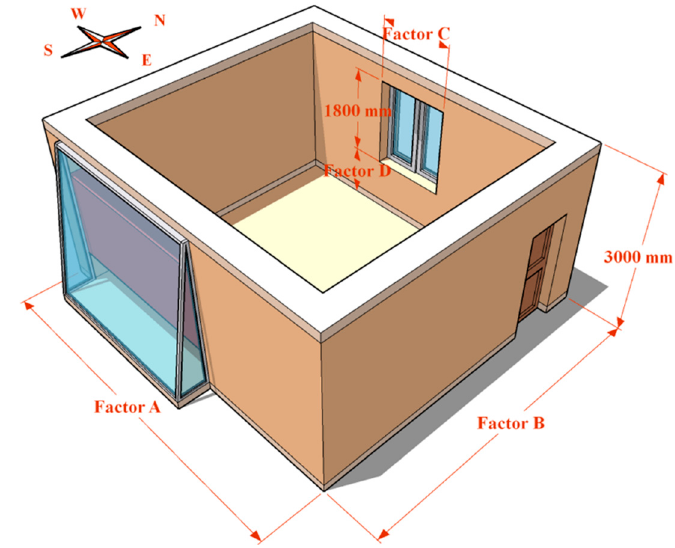
Figure 6. Diagram of influencing factors. Table 3. Orthogonal experimental design schemes and results.